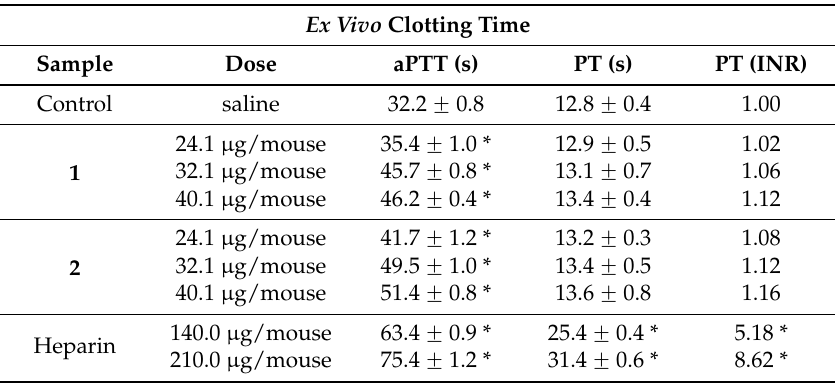
Table 4. Ex vivo clotting time of 1 and 2